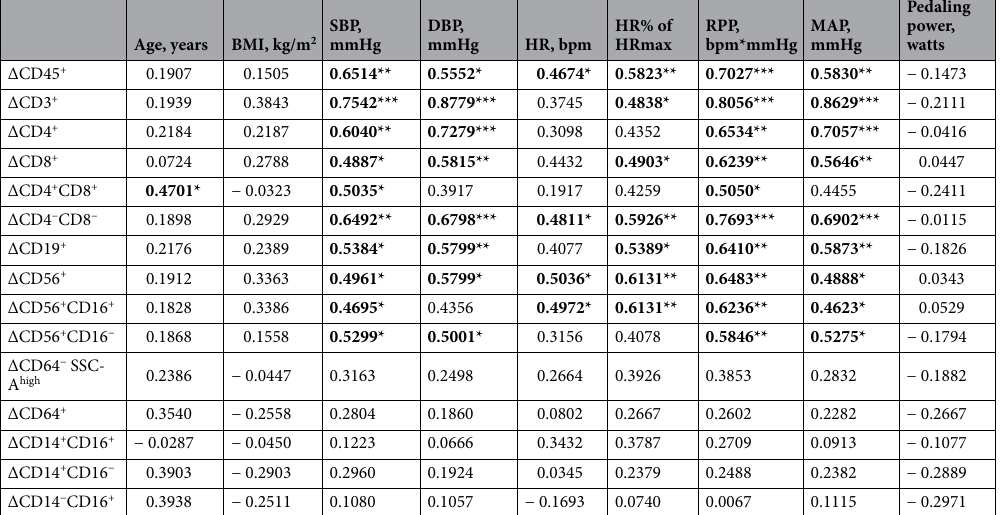
Table 2. Pearson correlation between age, BMI, and exercise intensity variables and change in the cell number between rest and exercise. Significant p values; * < 0.05, ** < 0.01, *** < 0.001. SBP systolic blood pressure; DBP diastolic blood pressure; HR heart rate; RPP rate pressure product; MAP mean arterial pressure. The correlations are calculated with exercising values of blood pressure, heart rate, RPP, and MAP. Significant values are in